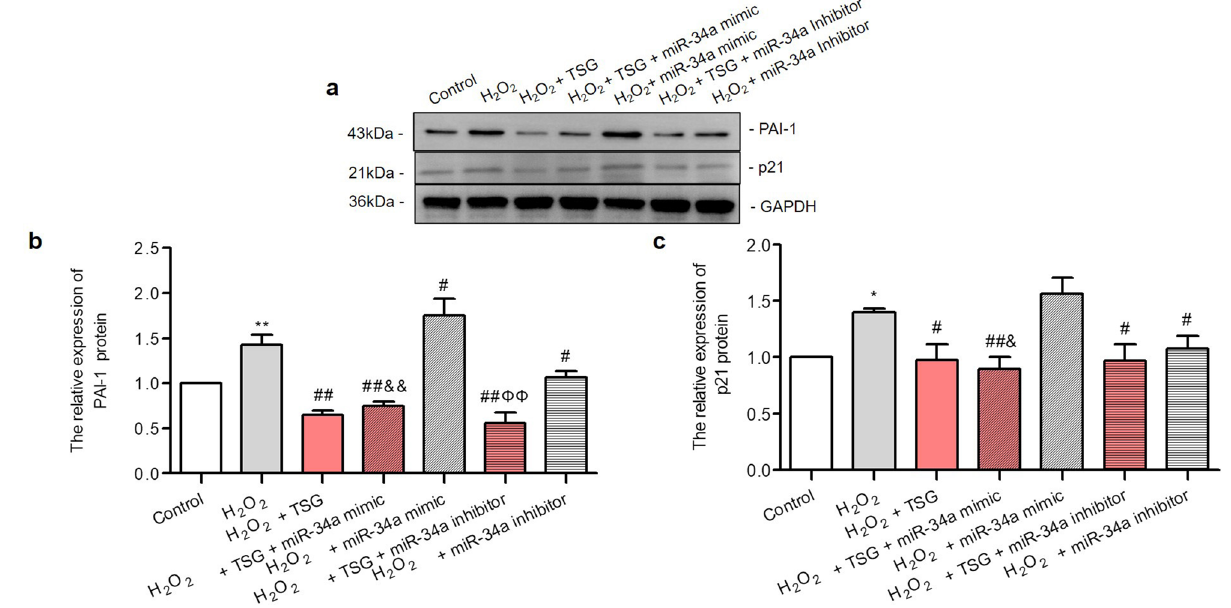
Figure 6. The effect of miR-34a over-expression or suppression on cell senescence related protein expression level of TSG on HUVECs induced by H 2 O 2 . HUVECs were transfected with miR-34a mimic or miR-34a inhibitor for 24 h, then treated with TSG for 24 h, and each group was finally induced by H 2 O 2 , except control group. ( a ) Representative images of the semi-quantification of p21, PAI-1 and GAPDH determined by Western Blot. GAPDH was used as an endogenous control. ( b ) The expression level of PAI-1 in each group. ( c ) The relative expression of p21 protein in each group. All groups of cells were treated with H 2 O 2 expect control group. Uncropped gel images are provided in the supplementary information. * p < 0.05 and ** p < 0.01 vs. control, # p < 0.05 and ## p < 0.01 vs. H $ p < 0.05 vs. H & p < 0.05 and && p < 0.01 vs. H 2 O 2 group, 2 O 2 + TSG group, 2 O 2 +